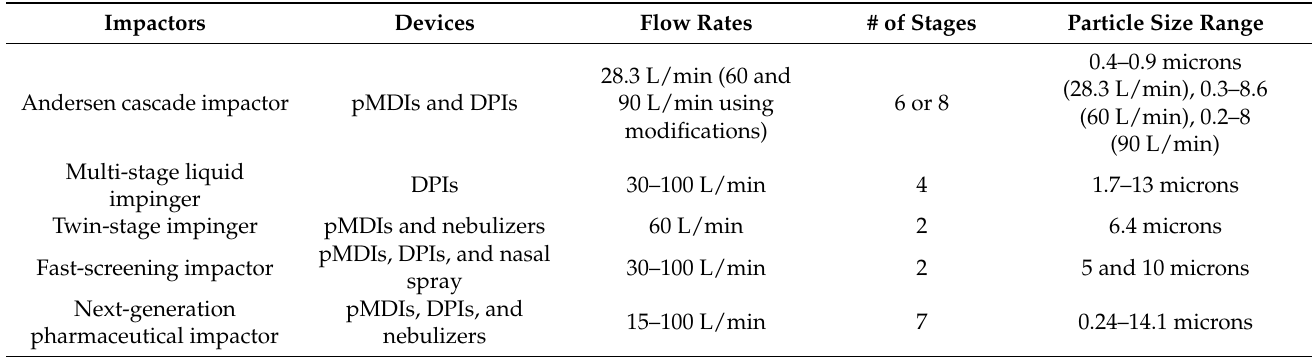
Figure 6. Types of impactors. ( A ) Andersen cascade impactor; ( B ) multi-stage liquid impinger; ( C ) twin-stage impinger; ( D ) next-generation impactor; ( E ) fast-screening impactor. Adapted from images from www.copleyscientific.com. Table 4. USP cascade impactors for orally inhaled device